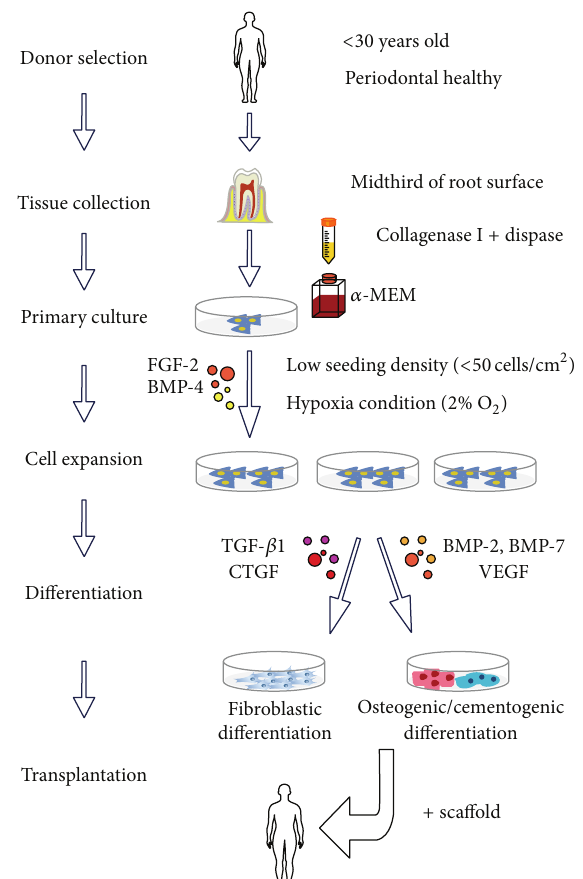
Figure1: Optimized conditions forisolationand cultureof periodontal ligament stemcells. Thisrepresentsan improved protocol forisolation and culture of PDLSCs. Optimal culture methods and conditions such as using enzymatic digestion, 𝛼 -MEM, and seeding cells at low density under hypoxia are recommended. Sequential use of different growth factors is effective for cell expansion and